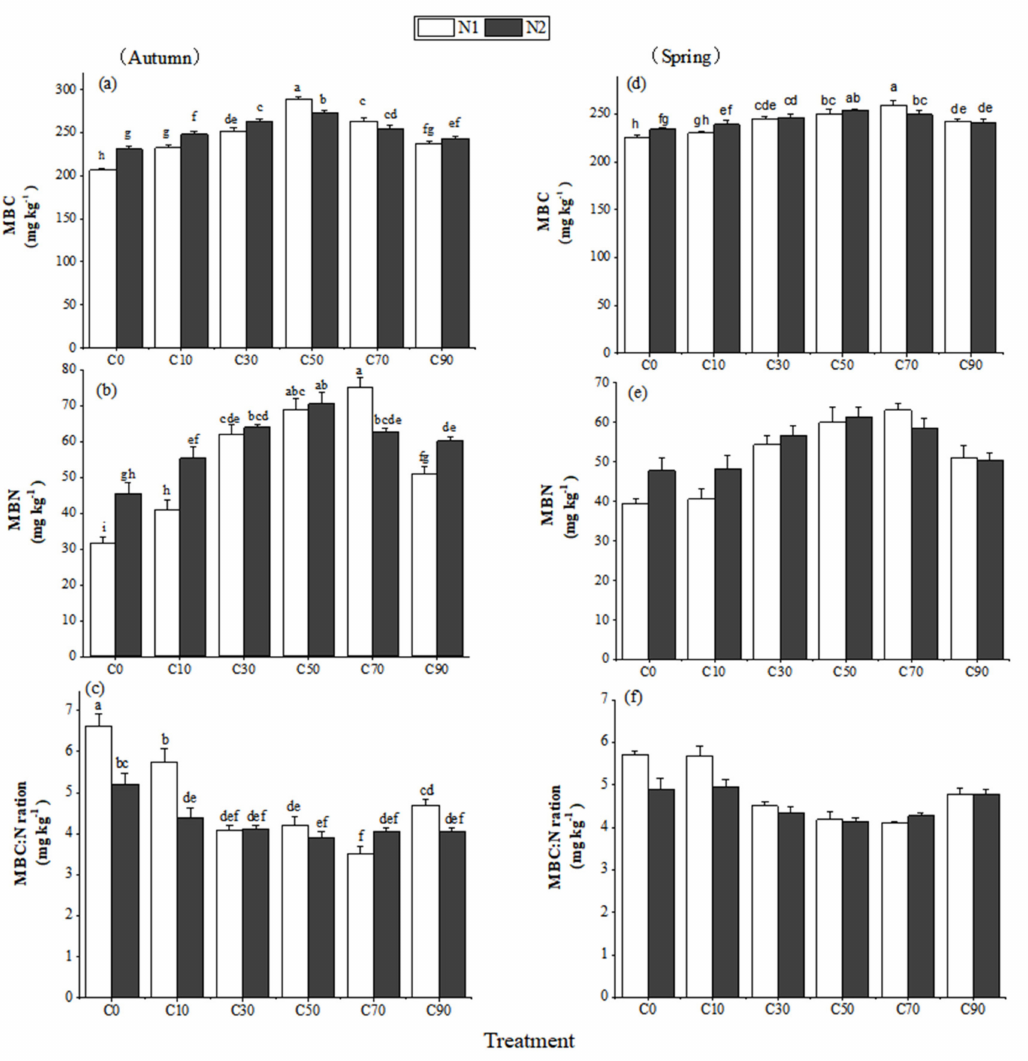
Figure 2. MBC, MBN, and MBC:N results for the treatments of different amounts of N fertiliser (N1 and N2) and biochar (C0, C10, C30, C50, C70, and C90). Error bars represent standard errors. Within each panel, different lowercase letters (a–i) denote significant differences among treatment means at the 0.05 level by Duncan’s MRT